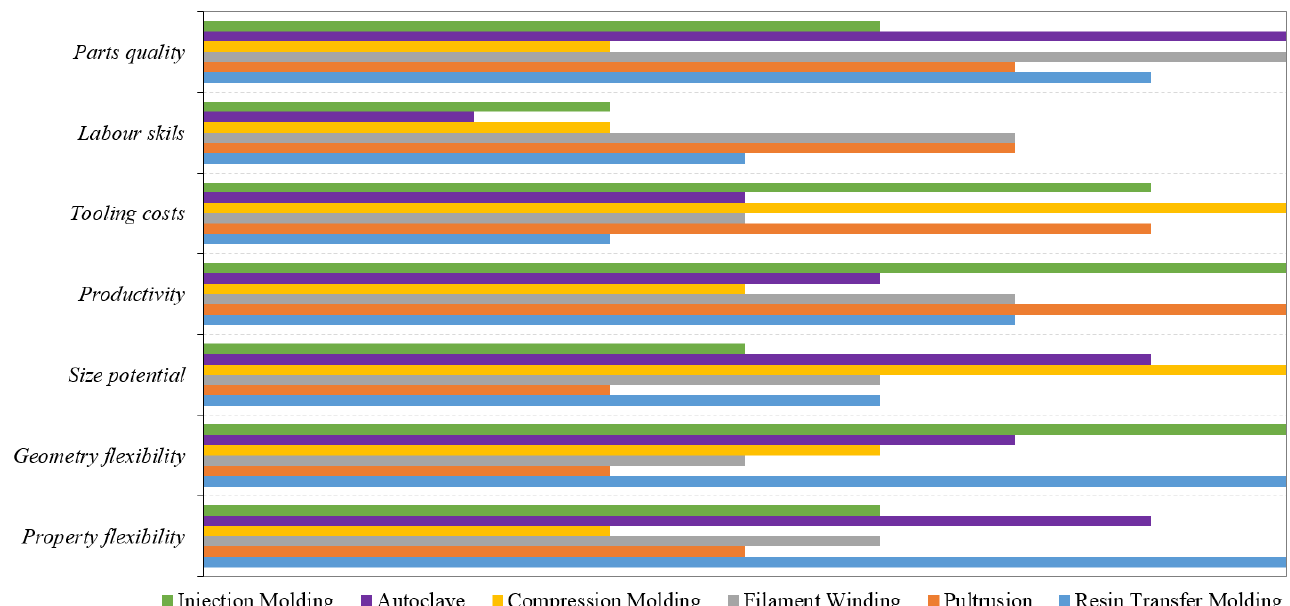
Figure 15. Comparison of different FRP manufacturing processes according to parts’ quality, labor skills, tooling costs, productivity, size potential, geometry and property flexibility [89].